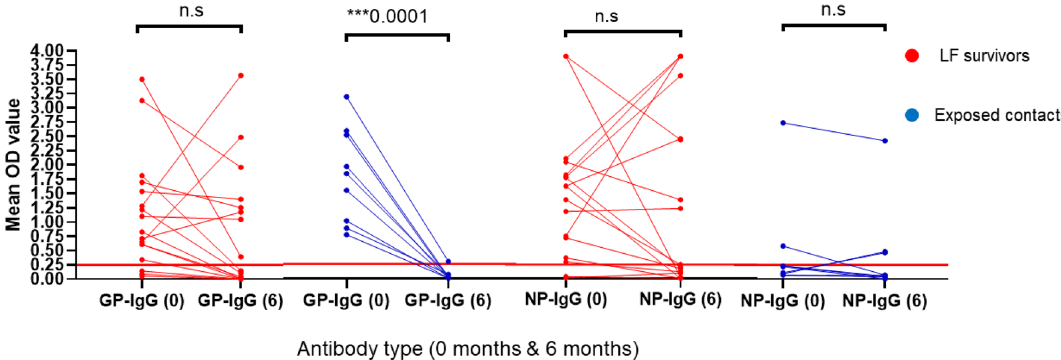
Figure 3. Binding antibody responses (IgG) to LASV GP and NP proteins from LF survivors and their contacts in Southern Nigeria six months post-infection. Durability of the binding antibody response (IgG) of a few LF survivors (N = 17) and their contacts (N = 9) was measured six months after the first sample collection using same specific LASV GP and NP ELISA (1:100 dilution). While most of the survivors retain their binding antibody responses, their contacts didn’t after six months. All the contacts lost their anti-GP IgG and only one retained anti-NP IgG. Statistical significance was calculated by Mann–Whitney test and p values are indicated. (Capped line with * indicating significance). The OD of the negative cutoff was selected as mean multiplied by three standard deviations of three known negative samples (0.25) for binding antibody (red line =